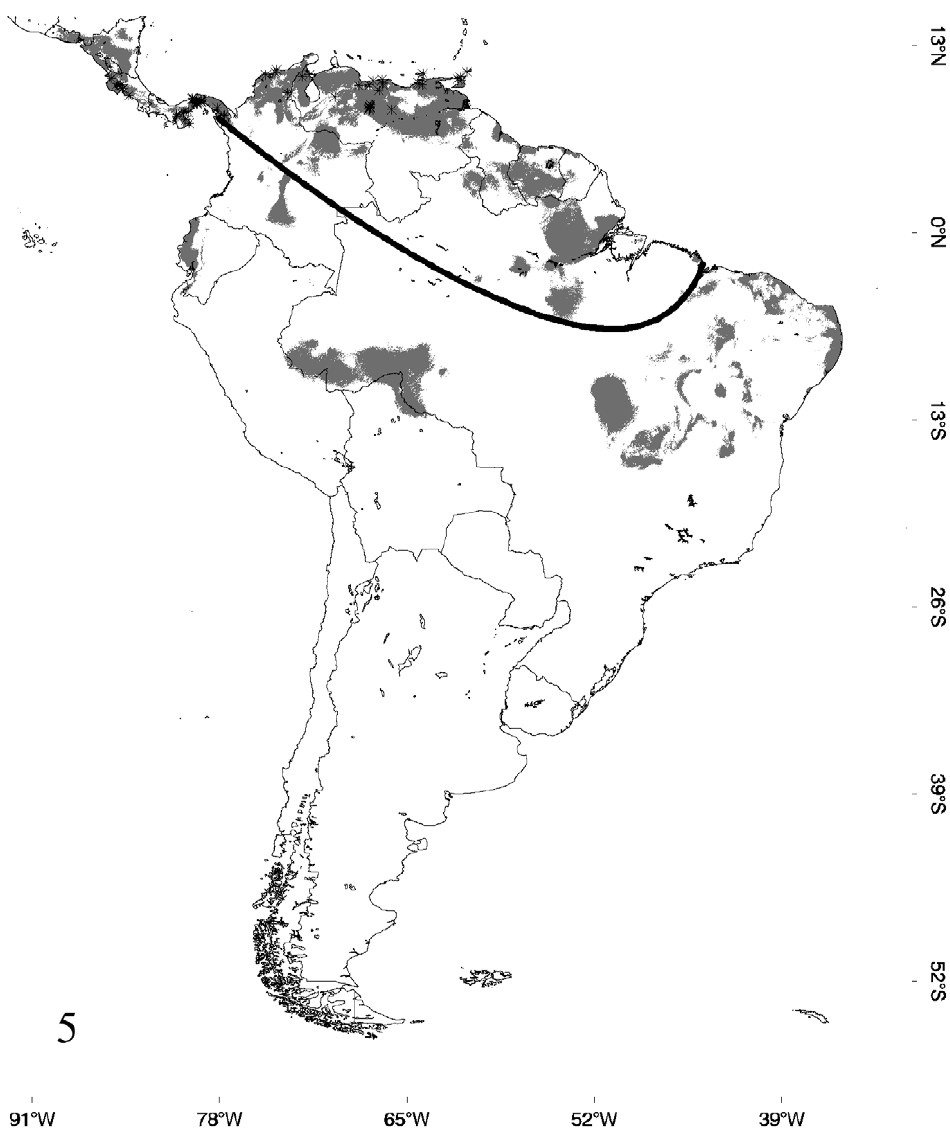
Figure 5. Occurrence probability map for Epicratesmaurus , determined by its respective model and points of occurrence. The areas below the line were not considered to calculate overlapping zones between species.